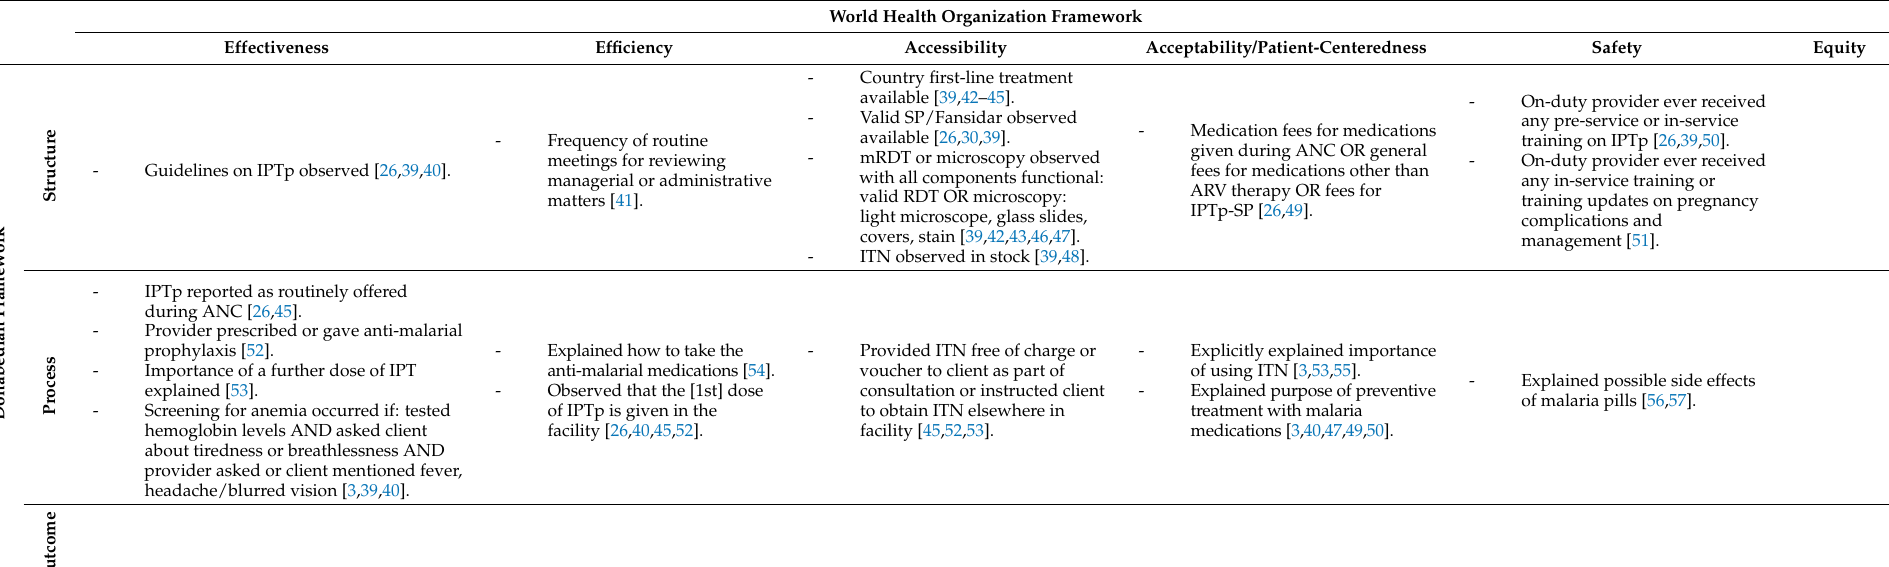
Table 1. Mapping of malaria in pregnancy quality indicators to combined quality framework